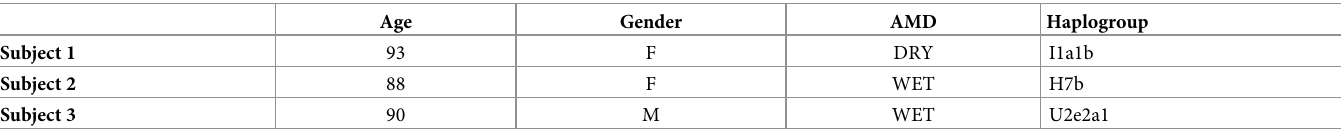
Table 1. Description of the AMD